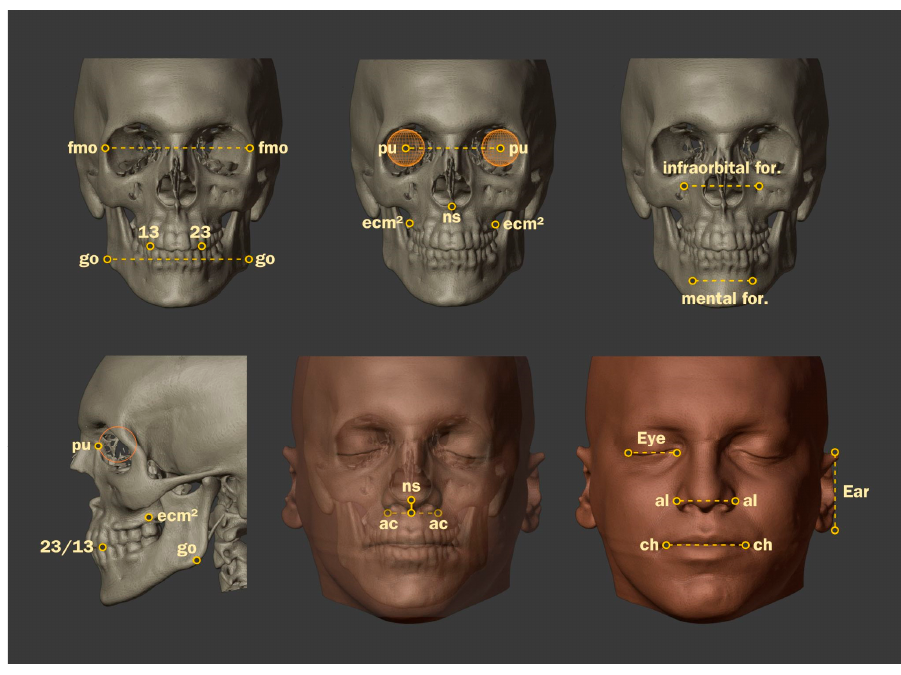
Figure 3. Important face measurements.